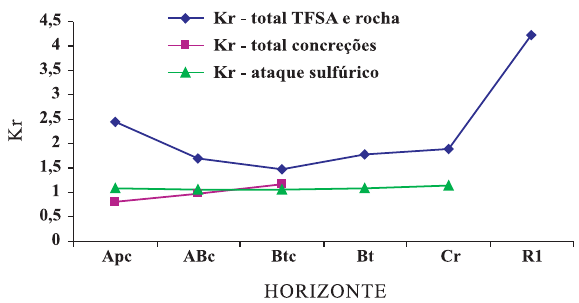
Figura 2. Índices de alteração intempérica